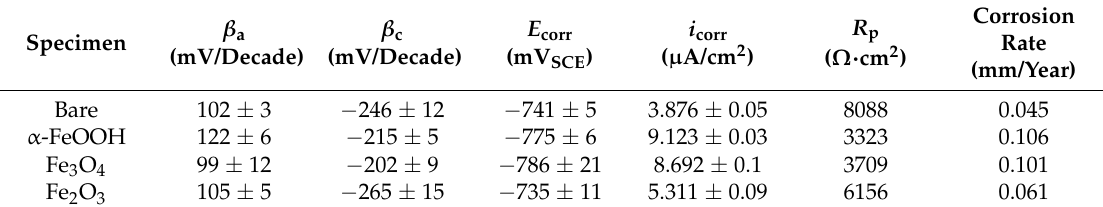
Table 3. Electrochemical parameters of the polarization curves of the bare specimen and iron oxides ( α -FeOOH, Fe 3 O 4 , Fe 2 O 3 )-covered specimens in the simulated district heating water at 40 °C. β c E corr i corr Corrosion Rate β a Specimen (mV/decade) (mV/decade) (mV SCE ) (mm/yr) Bare 102 ± 3 − 246 ± 12 − 741 ± 5